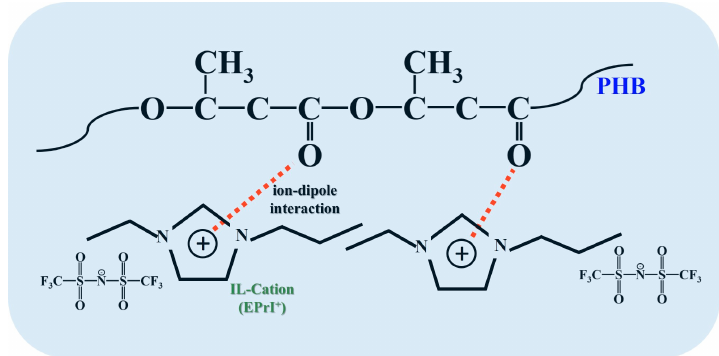
Figure 13. Illustration of the possible ion–dipole interaction between PHB and [EPrI][TFSI].